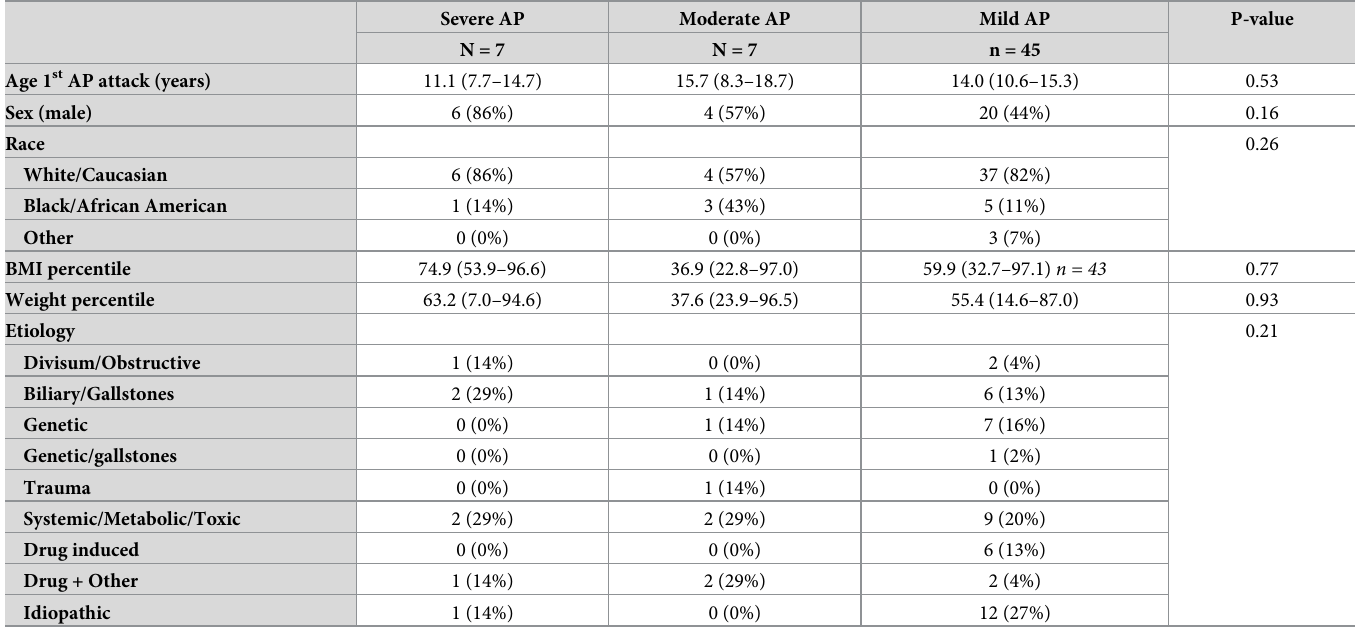
Table 1. First acute pancreatitis attack.